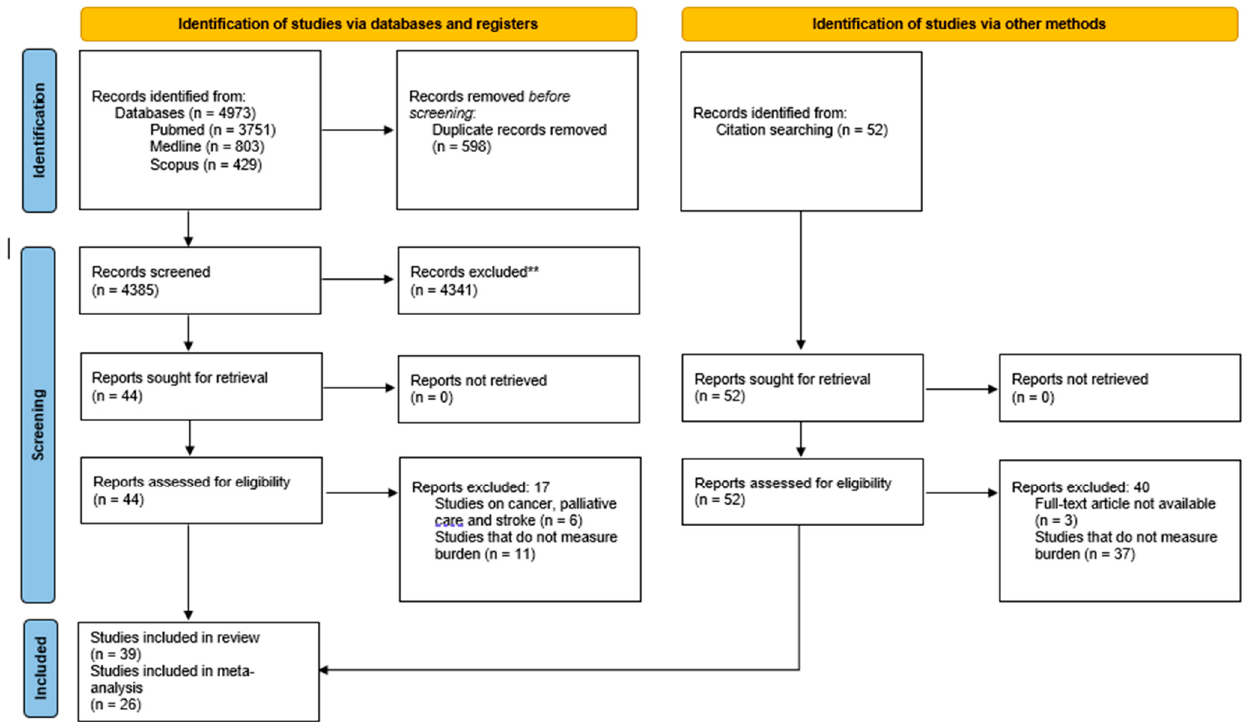
Figure 1. Preferred Reporting Items for Systematic Reviews and Meta-Analyses (PRISMA) flow diagram of the literature screening process.